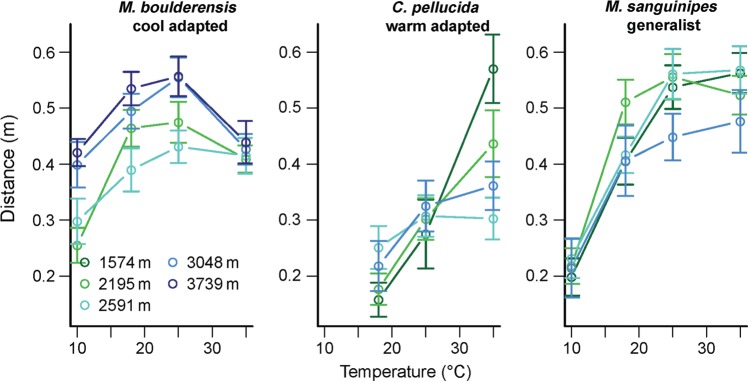
Hopping distance (in metres) as a function of temperature (in degrees Celsius) for field-collected grasshoppers. Mean values ± SEM are depicted, with colours distinguishing sites.